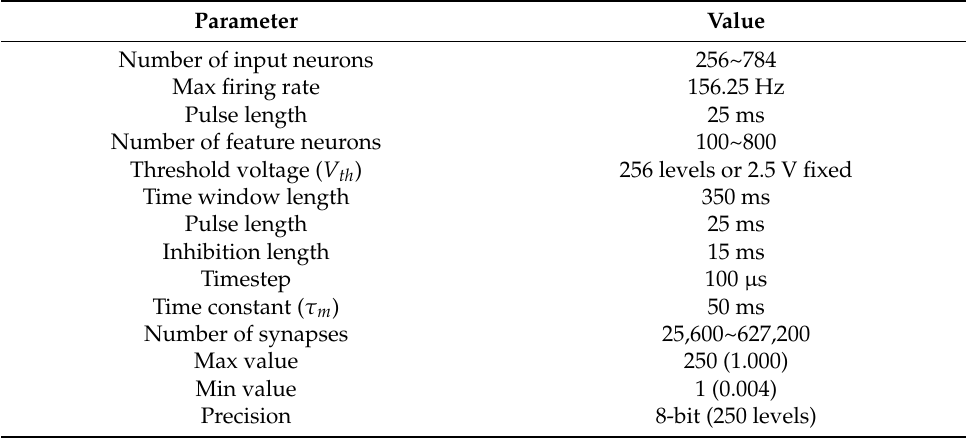
Table 1. Parameters of our spiking neural network.